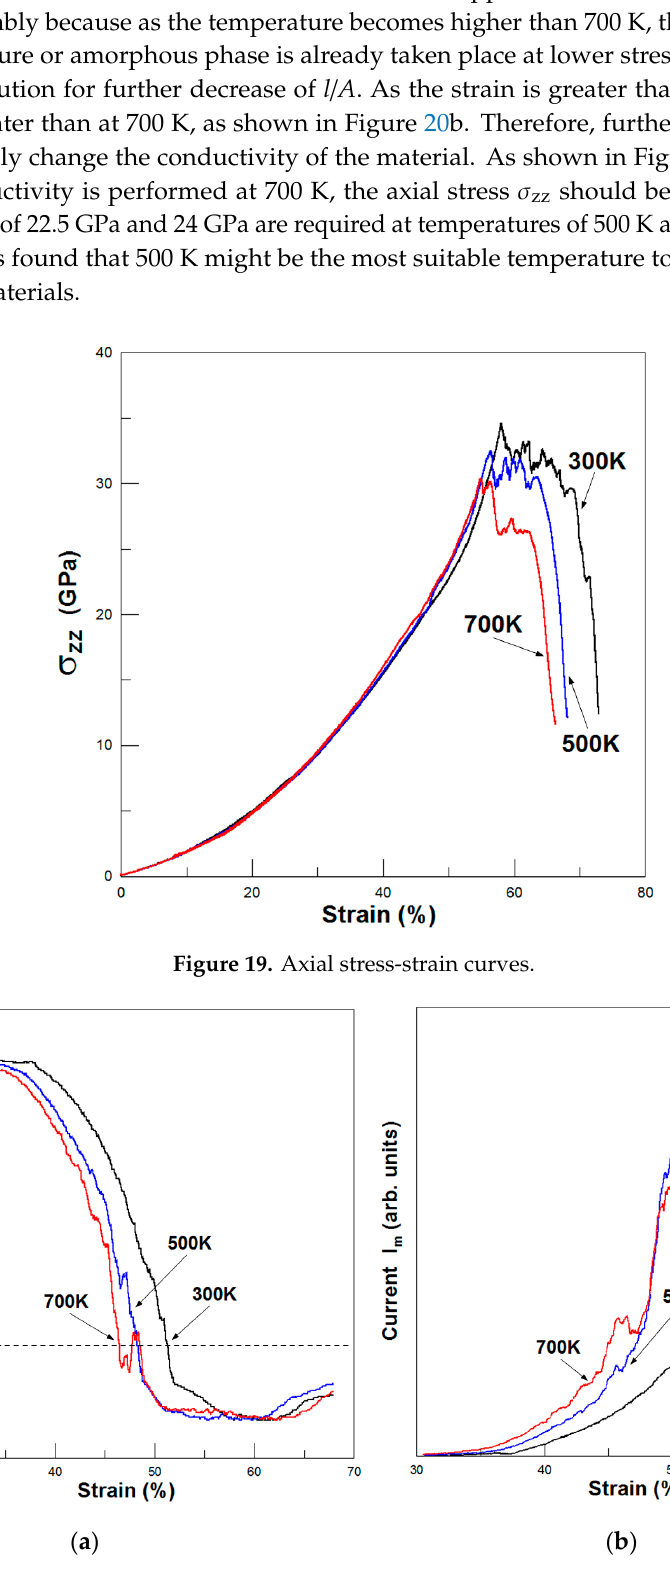
Figure 20. Resistance and current versus tensile strain of SiNW ( a ) resistance-strain curves; ( b ) current-strain curves.